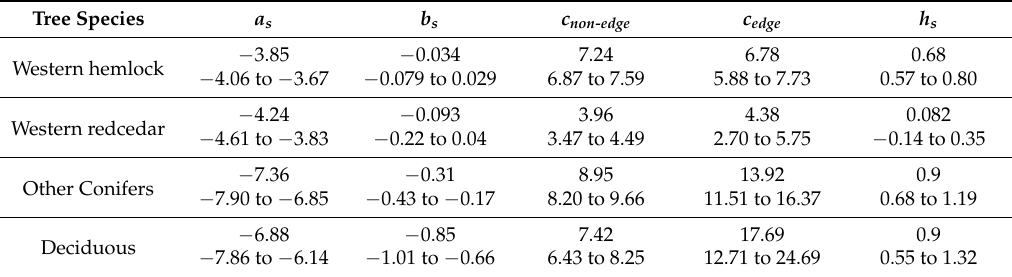
Table 2. Maximum likelihood parameter estimates (for variables defined in Equation 4) for Model 4a using relative DBH. Below each parameter estimate are the 2 unit asymptotic support